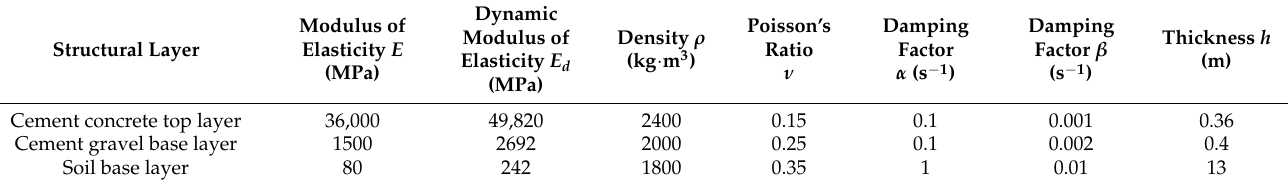
Table 4. Parameters of runway structural